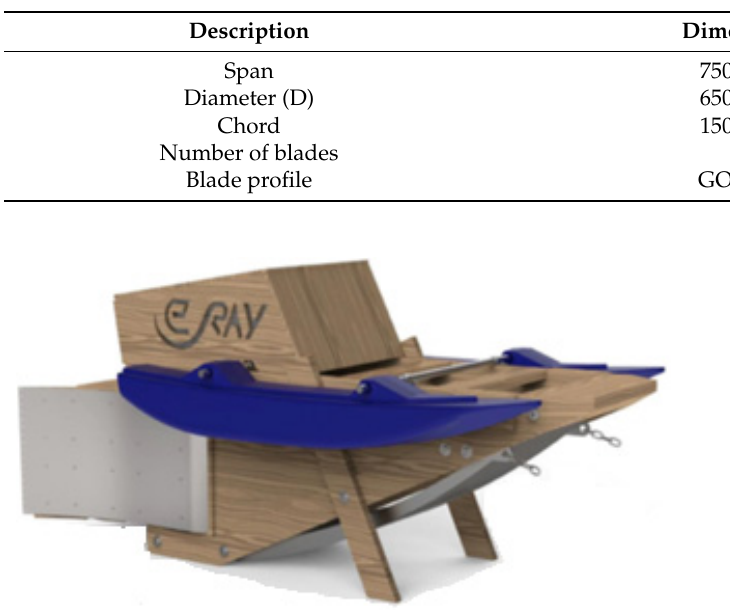
Table 1. Aerodynamic profile and turbine’s dimensions.